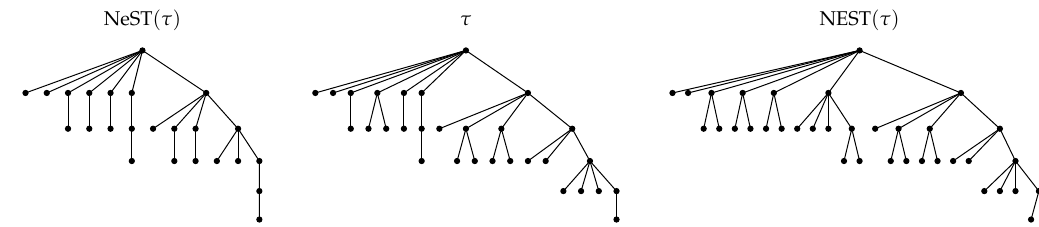
Figure 2. A tree τ ( middle ) with 30 nodes and its approximations NeST ( τ ) ( left ) with 24 nodes and NEST ( τ ) ( right ) with 37